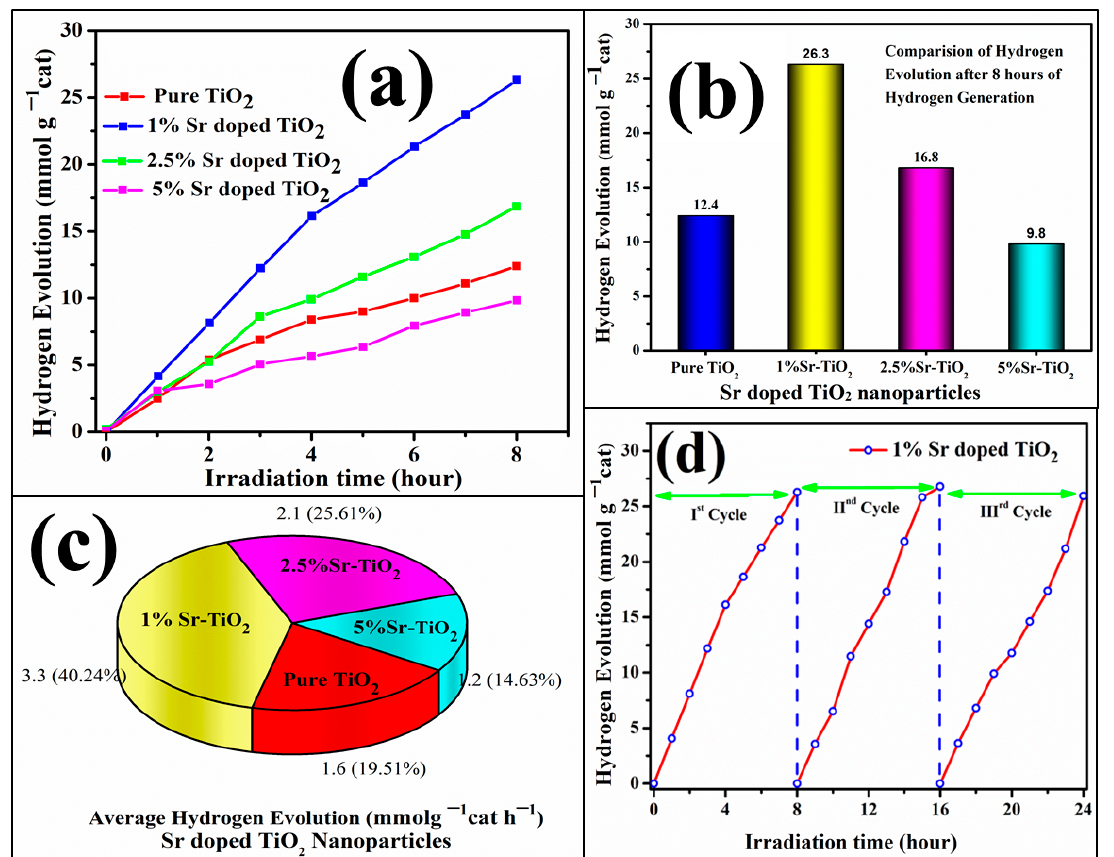
Figure 9. ( a ) Photocatalytic hydrogen evolution curves under UV-visible light irradiation as a function of irradiation time; ( b ) comparison of photocatalytic activity; ( c ) average H 2 evolution per hour of the pristine TiO 2 and 1, 2.5 and 5% Sr-doped TiO 2 NPs; ( d ) stability test of 1% Sr-doped TiO 2 for up to three